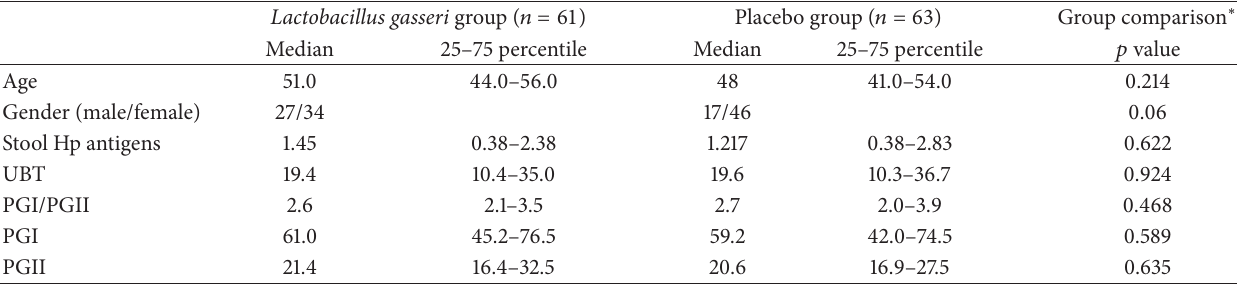
Table 1: Participant characteristics.